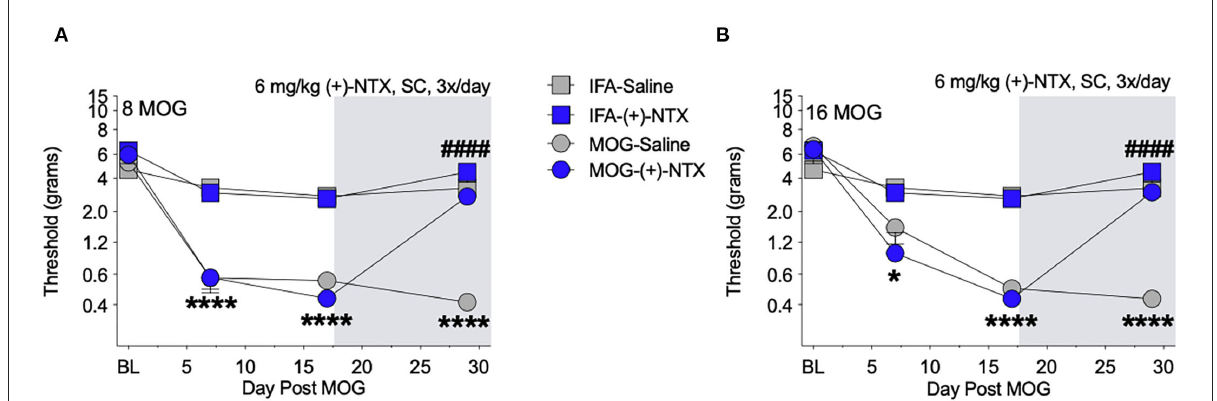
FIGURE4 Daily systemic administration of the TLR2–TLR4 antagonist ( + )-Naltrexone [( + )-NTX] reverses EAE-related pain in Sprague-Dawley (SD) rats. Sprague-Dawley (SD) rats were baselined (BL) for mechanical withdrawal thresholds via the von Frey test, followed by intradermal low-dose (0, 8, and 16 µ g) myelin oligodendrocyte glycoprotein (MOG). ( + )-NTX [6 mg/kg subcutaneously (SC) 3x/day] vs. saline was initiated on day 17 post-MOG, continuing through day 30 (see gray rectangle indicating span of drug delivery), and allodynia was assessed thereafter across the timecourse shown, continuing through day 30. All doses of MOG induced full mechanical allodynia by day 17, which lasted through day 29. (A) Main effects of day [ F (3, 84) = 100.80; p < 0.0001], treatment [ F (3, 28) = 47.51; p < 0.0001], and interaction between day and treatment [ F (9, 84) = 20.89; p < 0.0001]. (B) Main effects of day [ F (3, 72) = 82.07; p < 0.0001], [ F (3, 24) = 34.74; p < 0.0001], and interaction between day and treatment [ F (9, 72) = 17.73; p < 0.0001]. N = 8/group. Post-hocs : * indicates significant differences between 0 µ g MOG-saline and each dose of MOG; # indicates significant differences between MOG-saline and MOG-( + )-NTX.